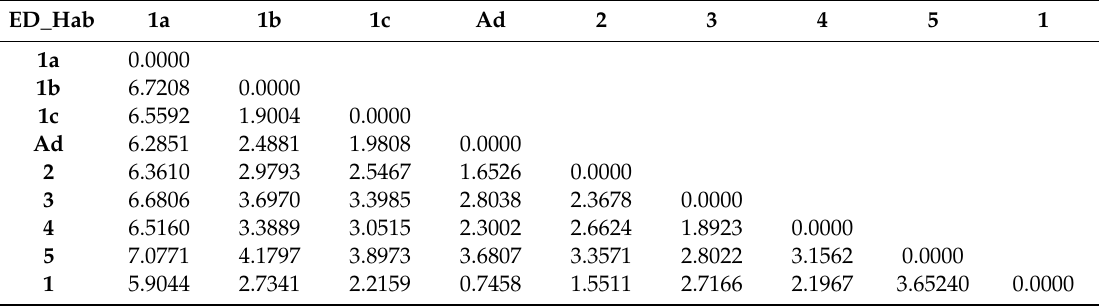
Table 4. Euclidean distance using the overlap operator according to Equation (8).